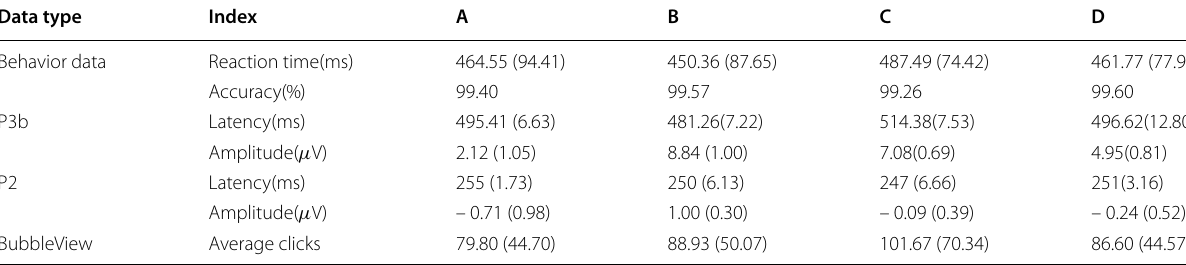
(In parentheses is the standard